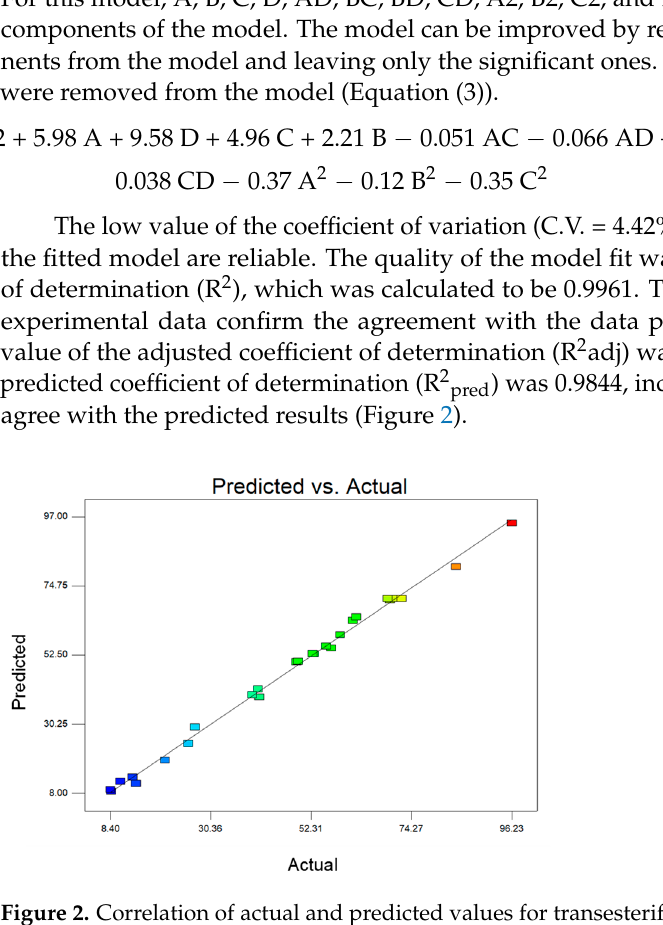
Figure 2. Correlation of actual and predicted values for transesterification yield. This means that the model is accurate and reliable for predicting and analysing the degree of transesterification of biodiesel. The value of the adjusted coefficient of determi- nation (R 2Adj. = 0.9930) is also very high, which confirms the significance of the model. A high value of predicted R 2 (0.9844) indicates that the fitted model is reasonably accurate. The corresponding precision value is 61.803 for the model. This value represents the sig- nal-to-noise ratio. A value greater than 4 is desirable. For this model, the corresponding precision value is more than 15 times the desired value. In this study, a ratio greater than 4 for adequate precision observed in all models validates that the model has an adequate signal, which indicates that the model can be used to navigate the design space. This was further supported by Figure 2, which shows that all the experimental values were scat- tered around the predicted values. As shown in Figure 2, the predicted values of trans- esterification yield obtained from the model and the actual experimental data were in good agreement. Based on the data of the initial analysis, three-dimensional (3-D) contour plots were compiled to assess the best conditions for the transesterification degree, as shown in Fig- ures 3A–D. Each figure examines the patterns of process response (transesterification de- gree), determining the relationships between the response and independent variables (amount of enzyme, the molar ratio of alcohol to oil, temperature, and duration). The val- ues of the dependent variables are selected in such a way as to obtain the maximum re- sponse value, and independent variables are fixed (on the X and Y axes). Figure 3 shows the effect of the transesterification degree on: Figure 3A—the molar ratio of alcohol to oil and the amount of the biocatalyst; Figure 3B—the molar ratio of alcohol to oil and the duration of the reaction; Figure 3C—temperature and the amount of the biocatalyst; Fig- ure 3D—the amount of biocatalyst and the duration of the reaction.